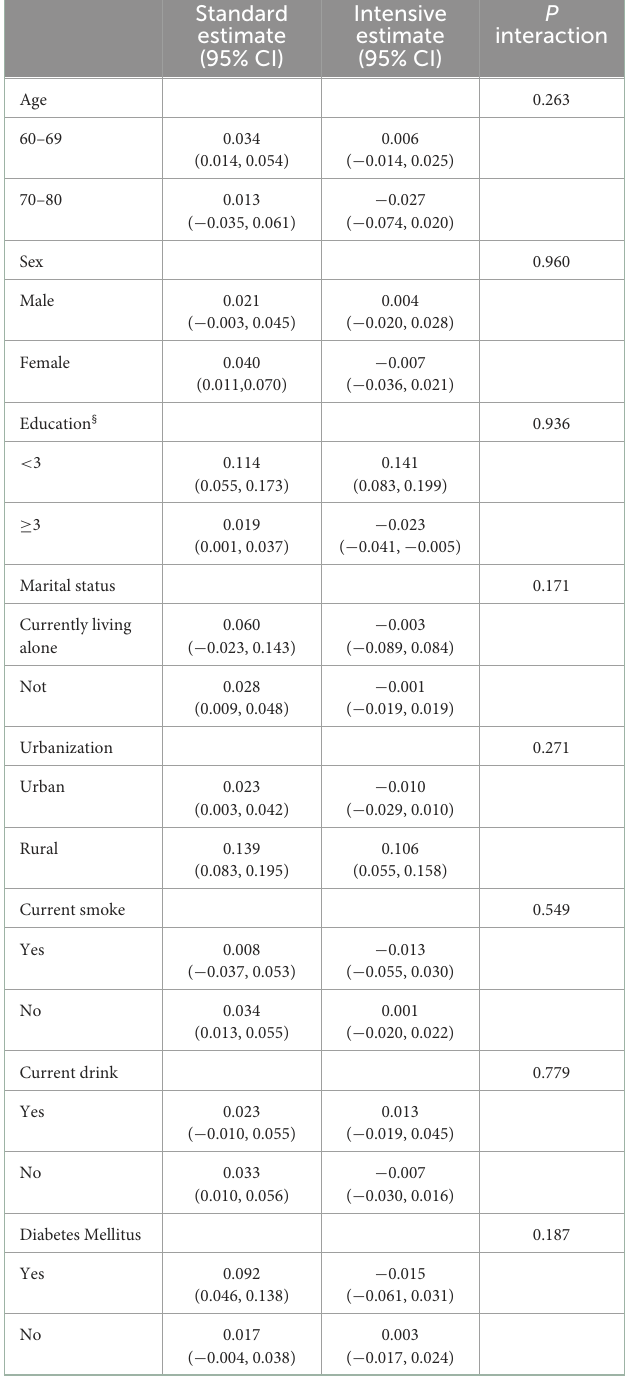
TABLE 3 Subgroup analysis of annual change in MMSE score ∗ .